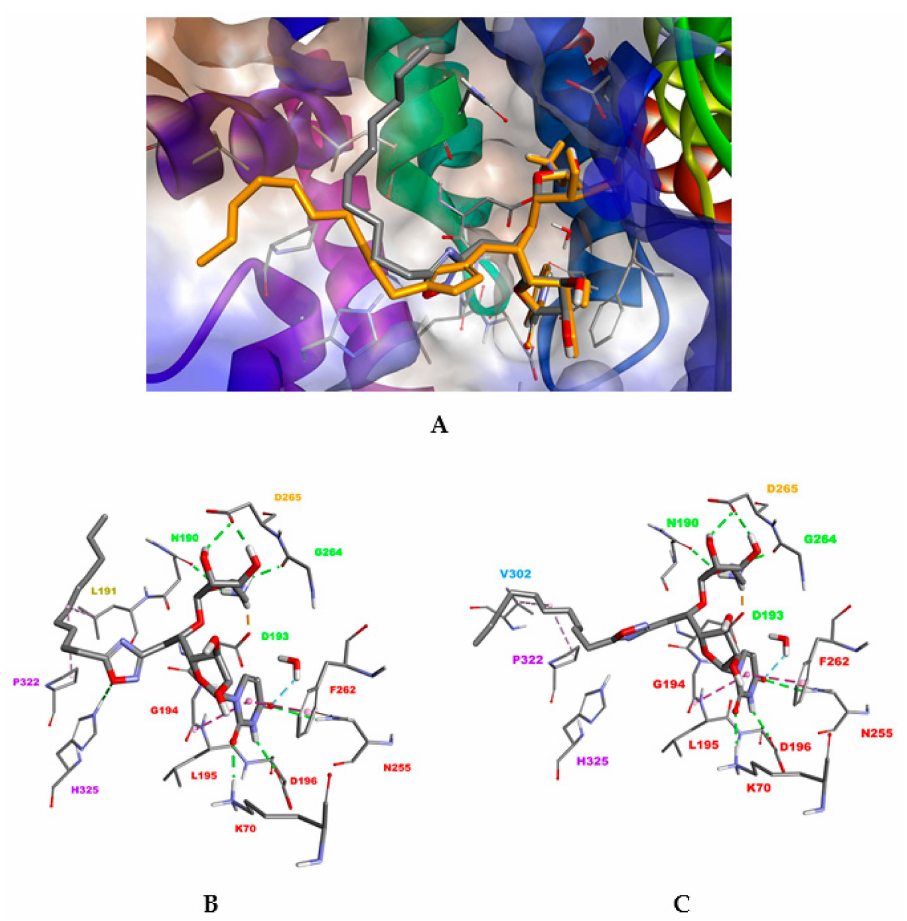
Figure 5. ( A ) Superimposition of the two docking conformations I and II, obtained for compound 12a in the open conformation of MraY AA (PDB ID: 5CKR). ( B ) Binding mode I. ( C ) Binding mode II. Ligand and residues are shown in stick mode. Interactions between the inhibitor 12a and MraY AA are shown as colored dashed lines: hydrophobic interactions (magenta), electrostatic interactions (orange) and hydrogen bond (green). For clarity, the apolar hydrogen atoms are